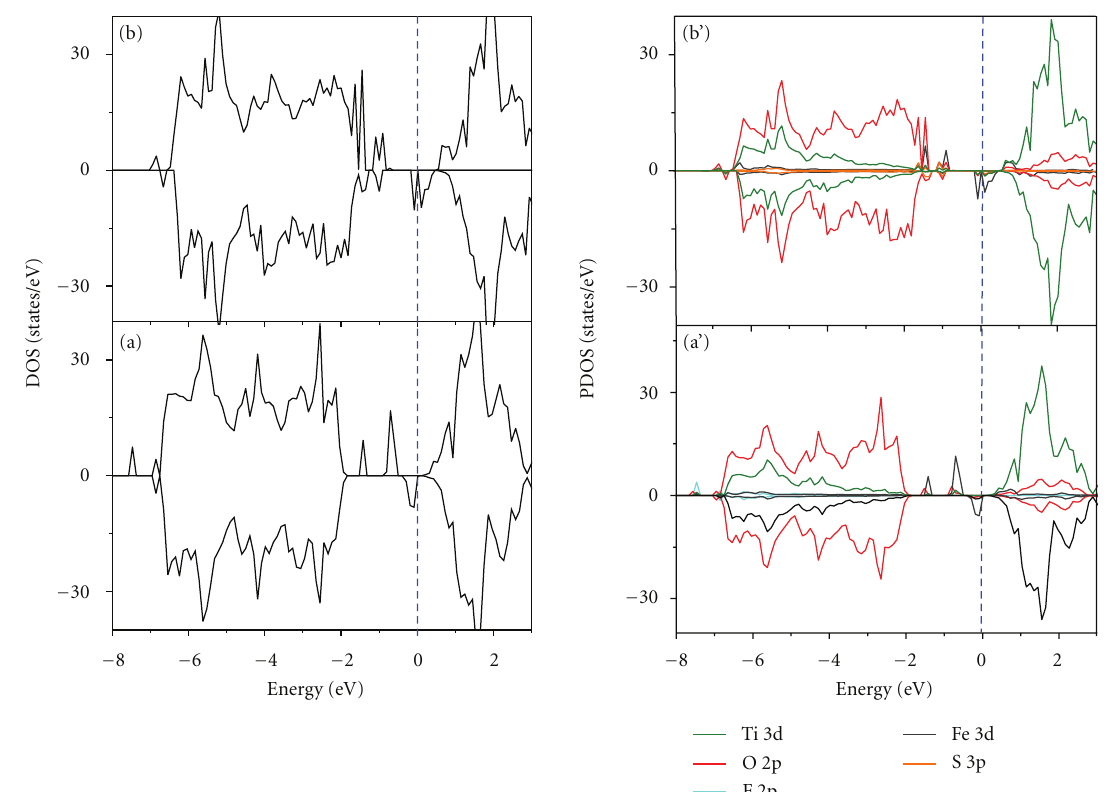
Figure 3: Total density of states (DOS) of (a) Fe-F codoped TiO 2 and (b) Fe-S codoped TiO 2 and projected density of states (PDOS) of (a (cid:3) ) Fe-F codoped TiO 2 and (b (cid:3) ) Fe-S codoped TiO 2 . The dashed line represents the Fermi energy